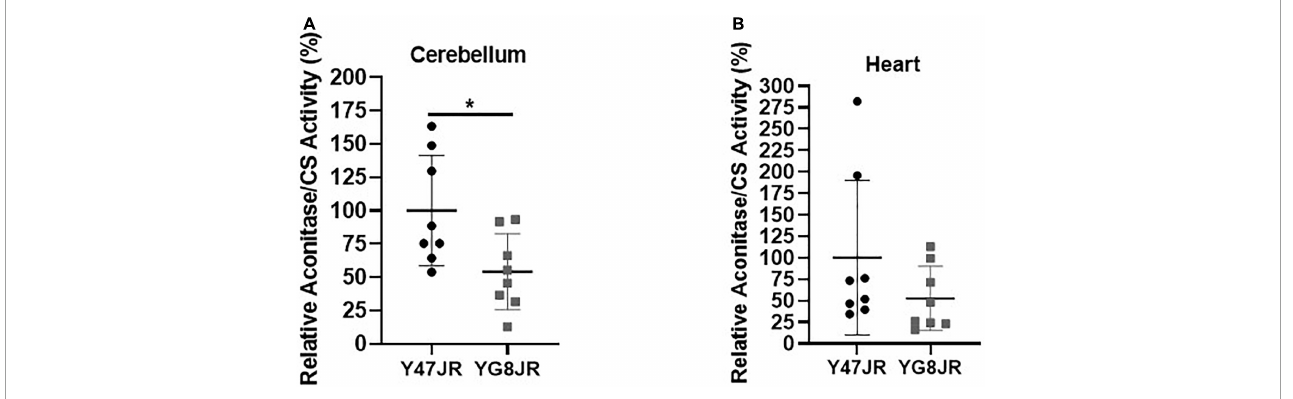
FIGURE6 Aconitase activity. Aconitase activity assay on (A) cerebellum and (B) heart tissues of YG8JR and Y47JR control mice. Relative aconitase activity normalized to citrate synthase (CS) activity from cerebellum and heart tissues ( n = 8 per group). YG8JR values were normalized to the Y47JR values that were set as 100%. Asterisks indicate significant differences between YG8JR and Y47JR, assessed by unpaired two-tailed Student’s t -test (* p <